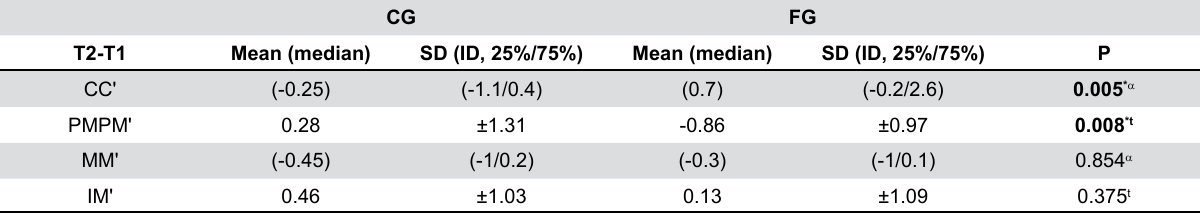
Table 3- Comparison of the intergroup differences (T2-T1=Δ)